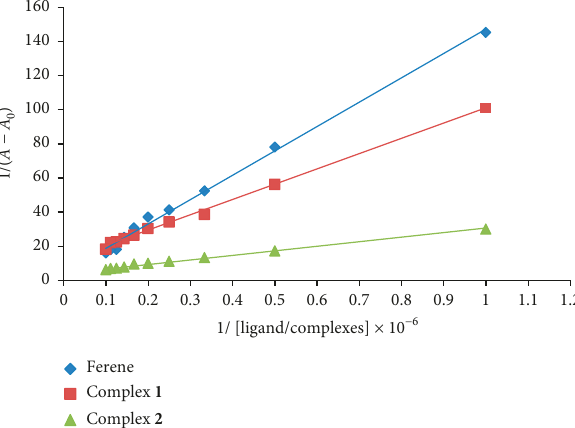
Figure 6: The graph of 1/( A ( R 2 (cid:30)